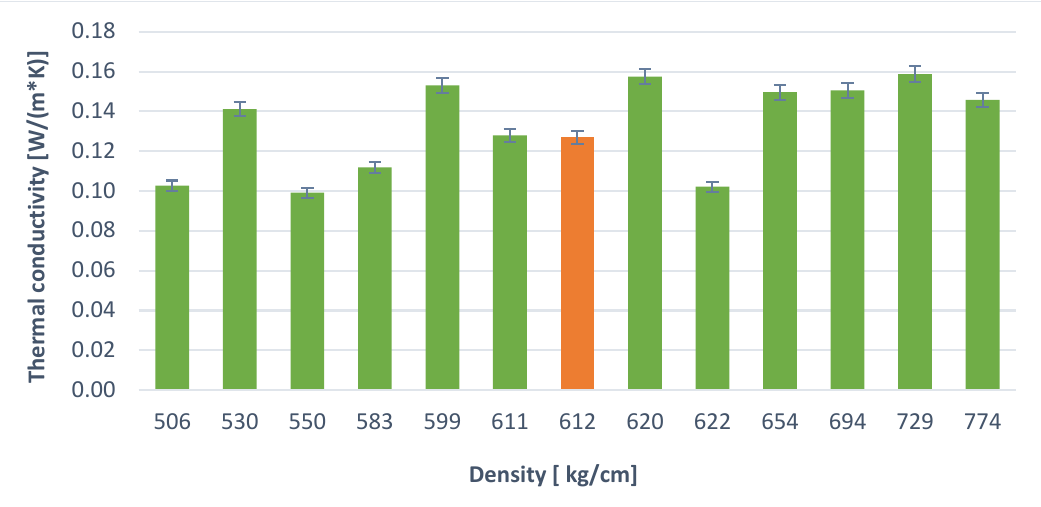
Figure 13. Relationship between thermal conductivity and density (samples with aluminum pow- der).